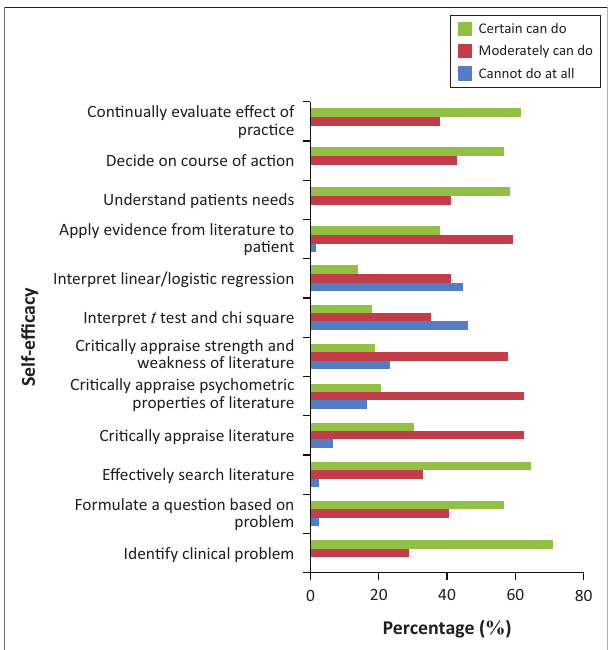
FIGURE 1: Self-efficacy in performing evidence-based practice for stroke survivors.